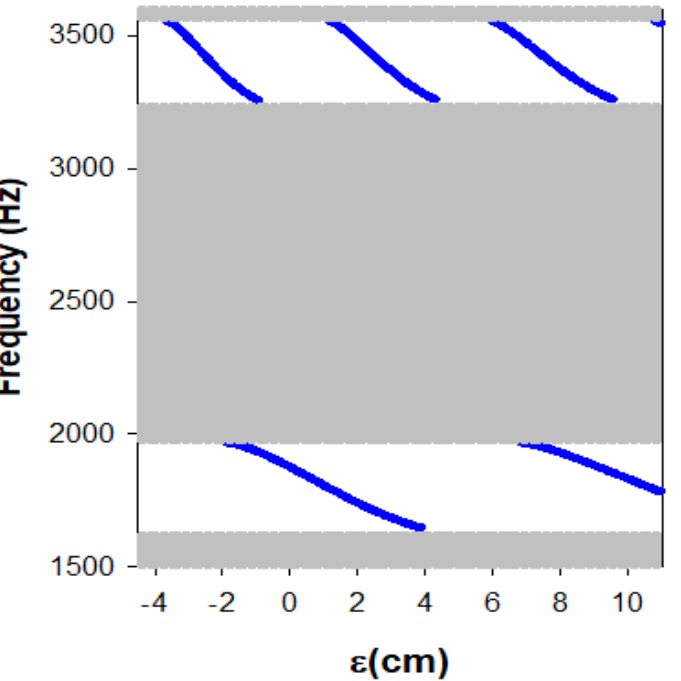
= d (cid:48) = 10 cm 2 1